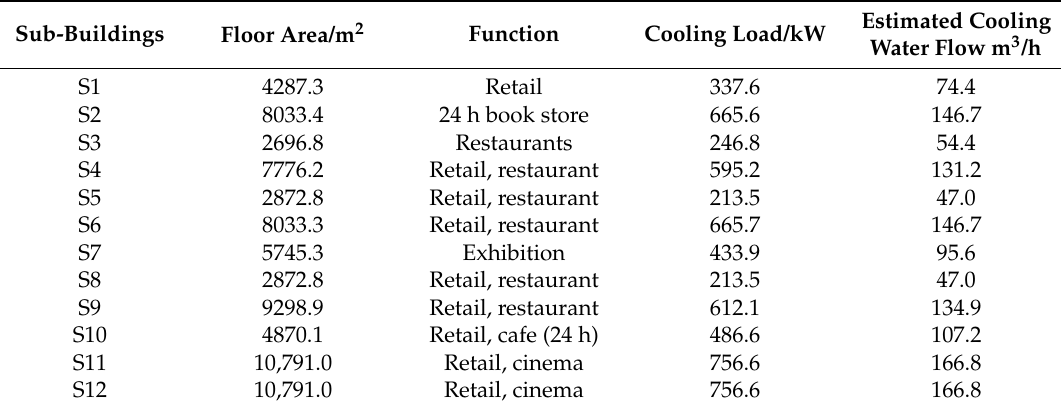
Figure 5. Comparison between simulation and field test results for the entire district cooling project. Table 1. Basic information of sub-buildings.